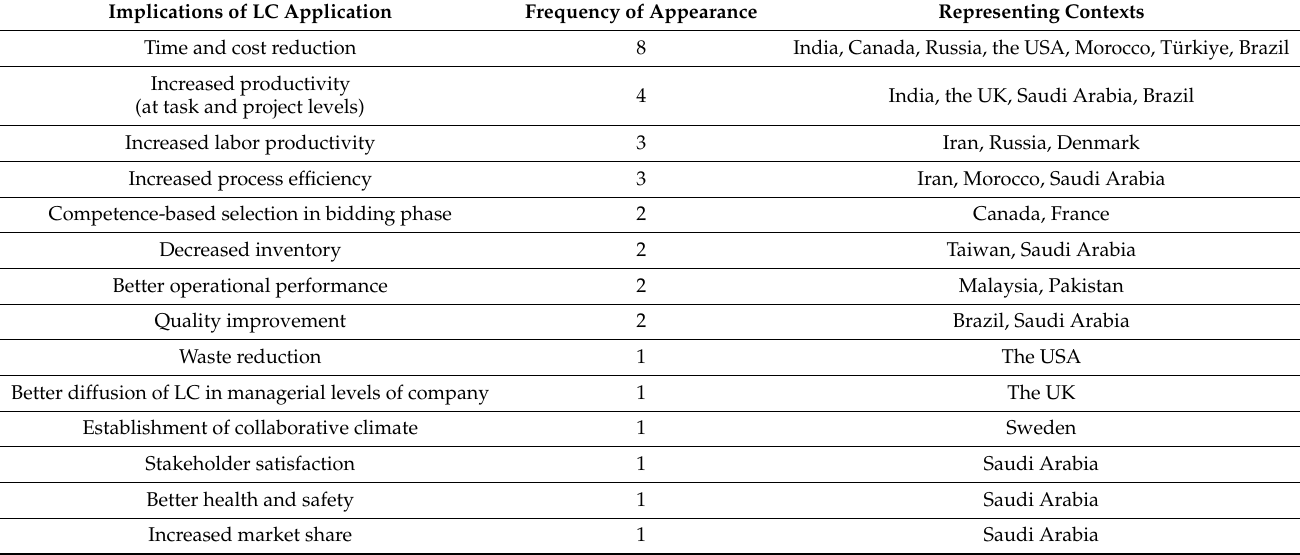
Table 2. Implications of adopting and implementing lean